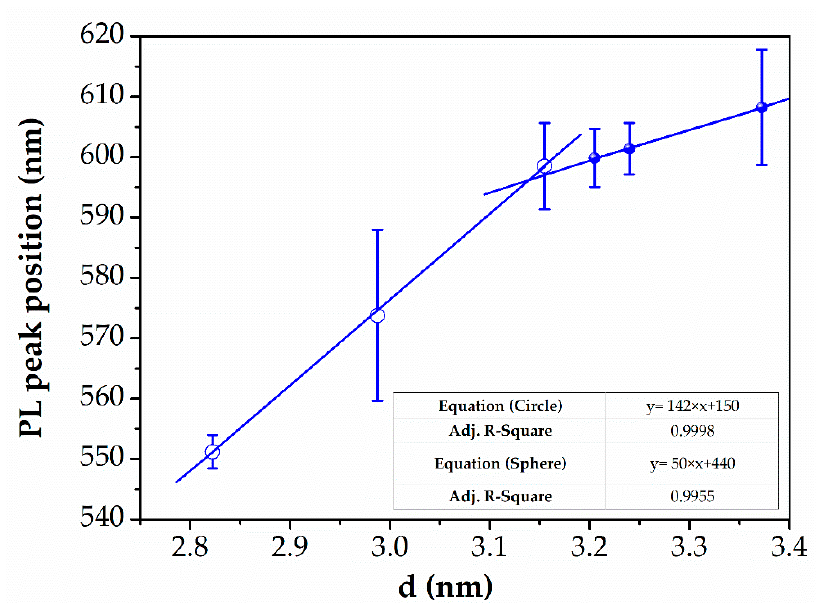
Figure 4. PL peak position as a function of CdTe QDs size grown in film (the first linear fit for the growth of CdTe QDs from 5 to 20 min is reported as solid line and circles; the second linear fit for the growth of CdTe QDs from 30 to 120 min is reported as solid line and spheres).